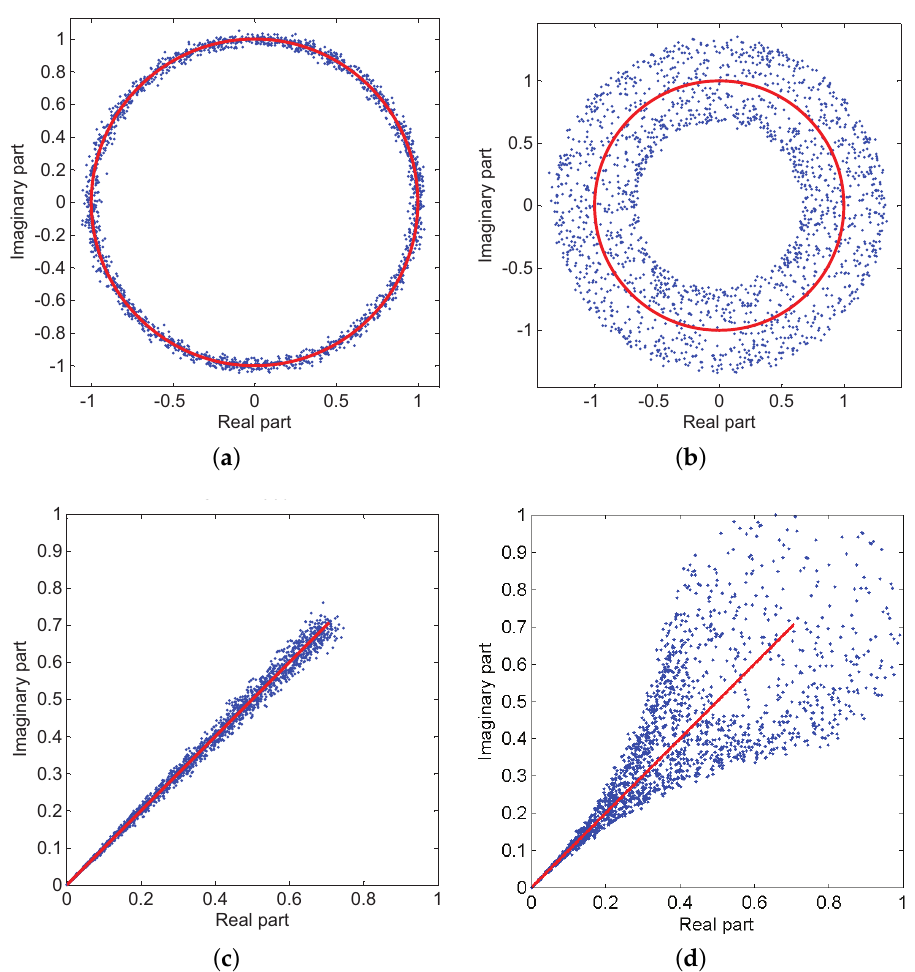
Figure 3. Amplitude and phase mismatches. ( a ) Amplitude mismatches without the traffic interfer- ence. ( b ) Amplitude mismatches in the presence of traffic. ( c ) Phase mismatches without the traffic interference. ( d ) Phase mismatches in the presence of